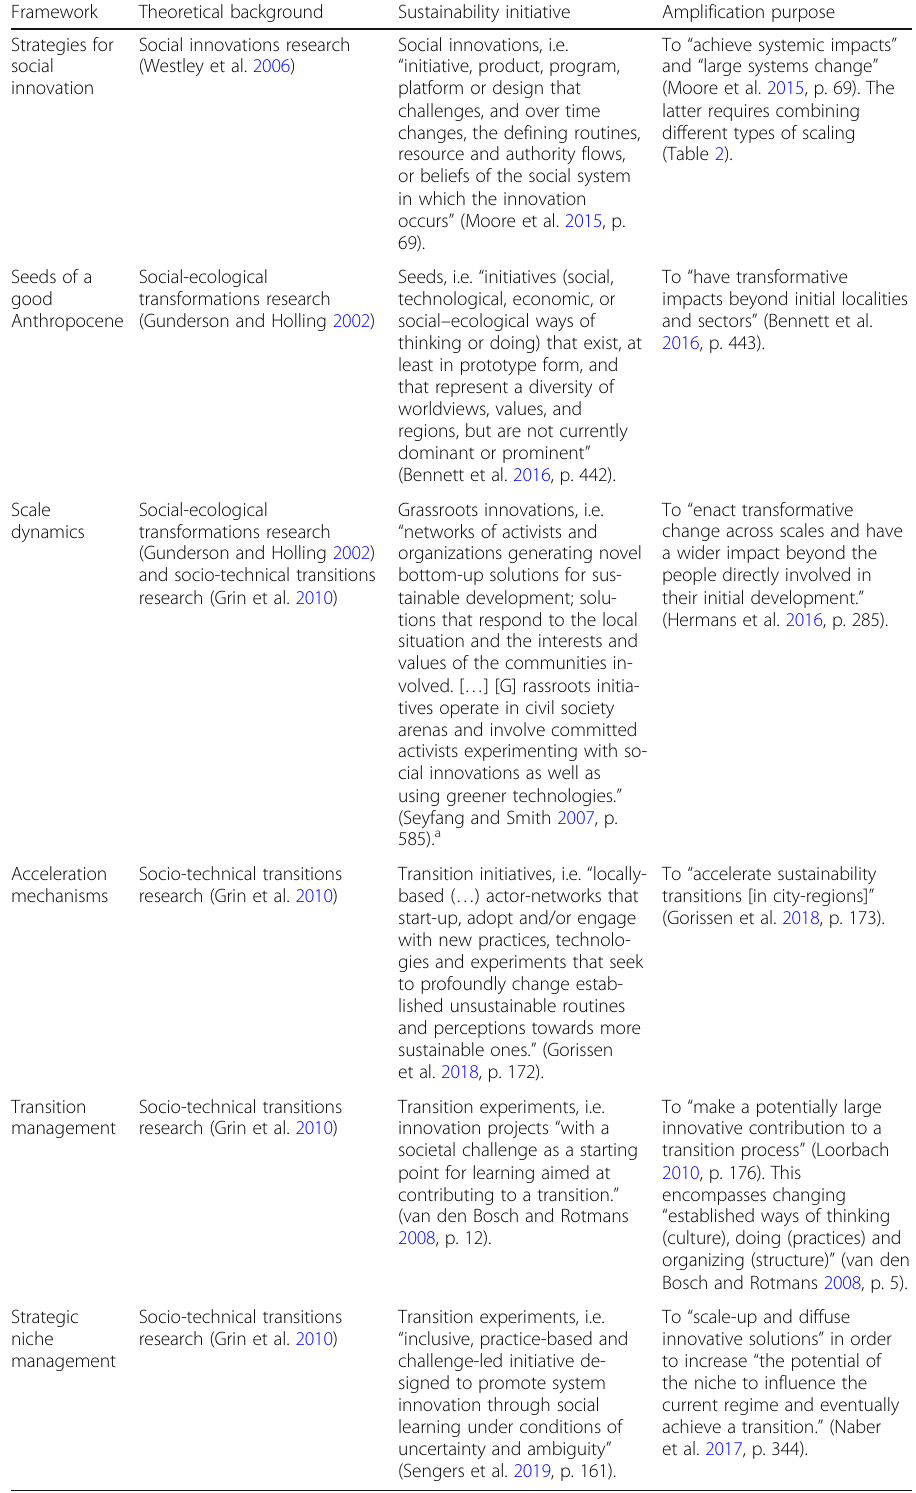
Table 1 Amplification